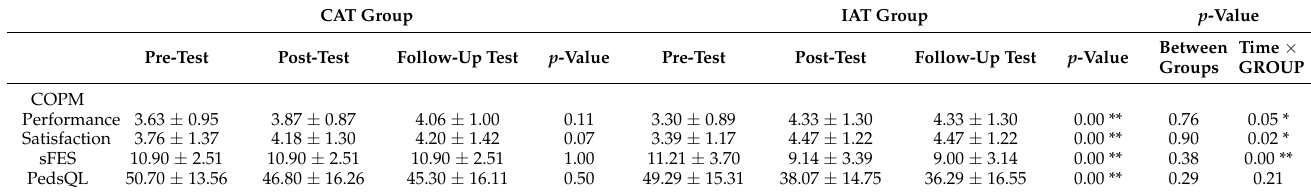
Table 3. The outcome analysis on social integration